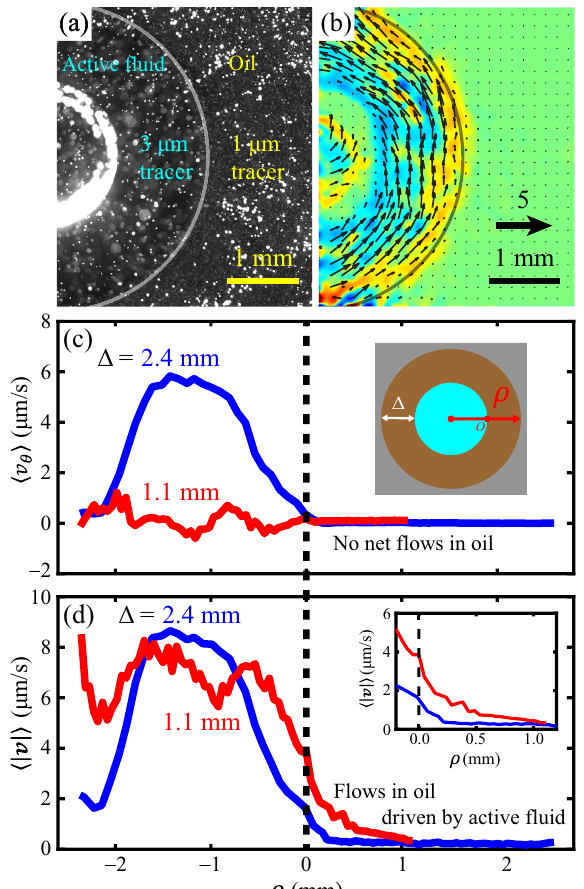
Figure 5. Active fluid droplets induced chaotic flows in the surrounding oil. ( a ) Micrograph of an active droplet ( r 2.4 mm, h 1 mm) immersed in oil ( (cid:31) 2.4 mm). To track the flows, both the active fluid and oil were ≈ = ≈ doped with tracers. The gray curve represents the water–oil interface. ( b ) Time-averaged normalized velocity field and vorticity map revealed circulatory flow in the droplet but no net flow in the oil. The velocity field and vorticity map were plotted as in Fig. 1c. ( c ) Midplane flow profiles of azimuthal velocities of two droplets with the same shape ( r 2.4 mm, h 1 mm) but different oil layer thicknesses ( (cid:31) 2.4 mm, blue curve; (cid:31) ≈ = ≈ ≈ 1.1 mm, red curve) show that the thicker oil layer supported intradroplet circulatory flows, whereas the thinner layer did not. The dashed vertical line indicates the water–oil interface. Regardless of how the active fluids flowed within the droplets, the oil developed no net flow. Inset: Schematic of horizontal axis of the plot, ρ . ρ > 0 represents the oil region; ρ < 0 represents the droplet region. ( d ) The flow speed profiles for both droplets extended across the water–oil interface into the oil region ( ρ > 0 ). This shows that the active fluid flows near the interface drove flow in the nearby oil. Inset: Close-up of the profiles near the water–oil